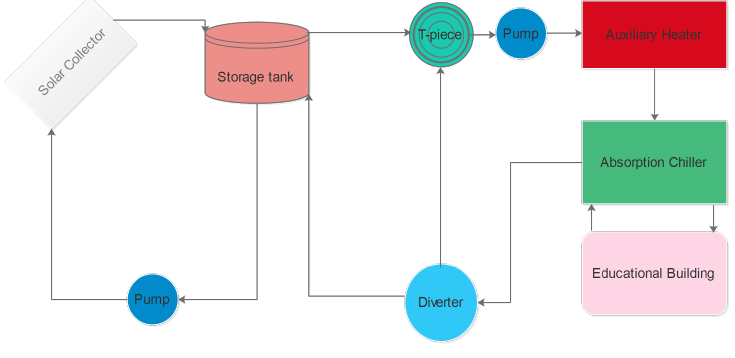
Figure 1. Solar absorption cooling